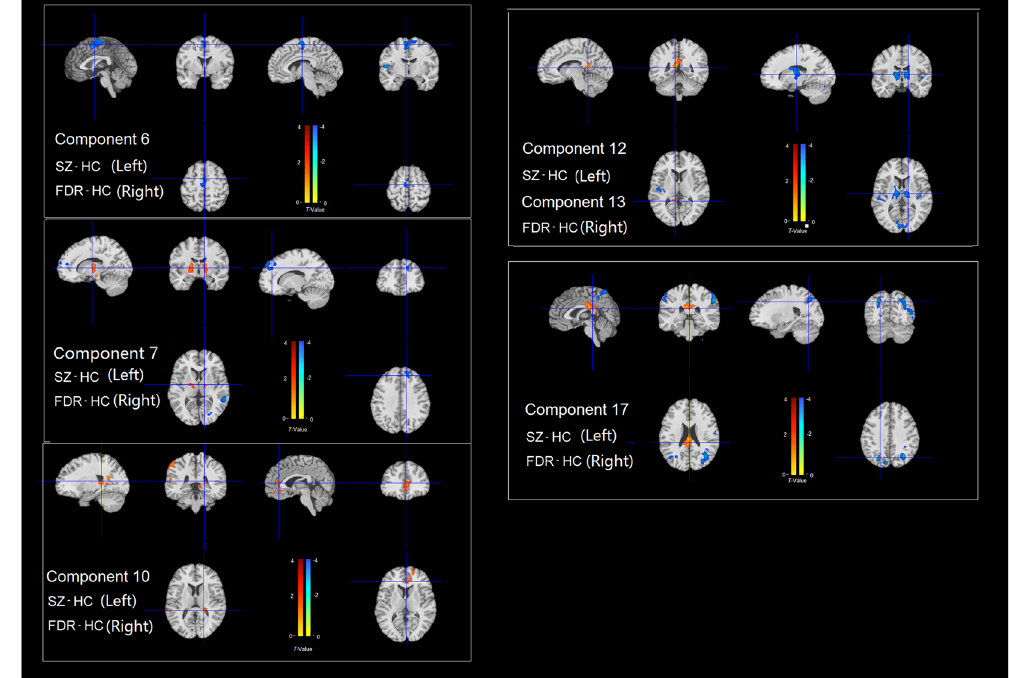
Supplementary Table S1. SZ-HC: differences in functional connectivity within the network between patients and healthy controls. FDR-HC: differences in functional connectivity within the network between first-degree relatives and healthy controls. The statistical threshold was p < 0.05, alphasim corrected. SZ, schizophrenia patients; FDR, first-degree relatives; HC, healthy